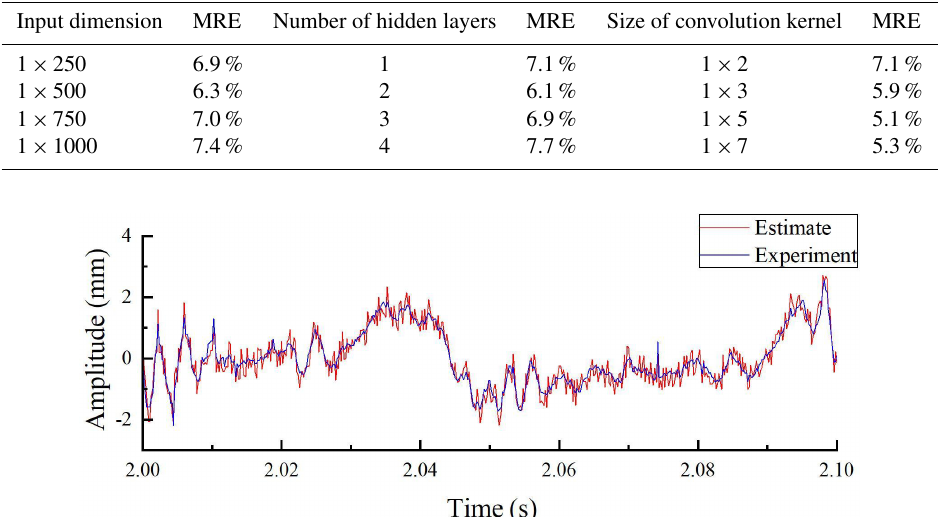
Table 2. Comparison of each super parameter.